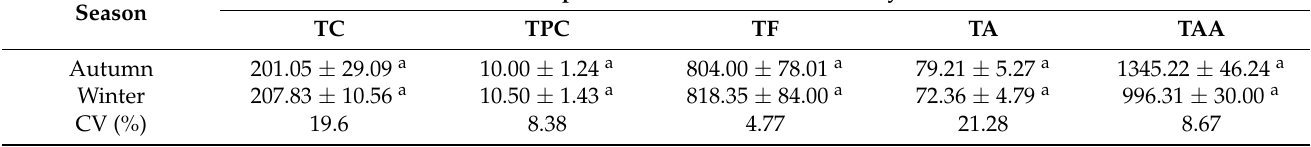
Table 3. Mean values ± standard deviation of contents of TC (mg 100 g − 1 dry sample), TPC (in g